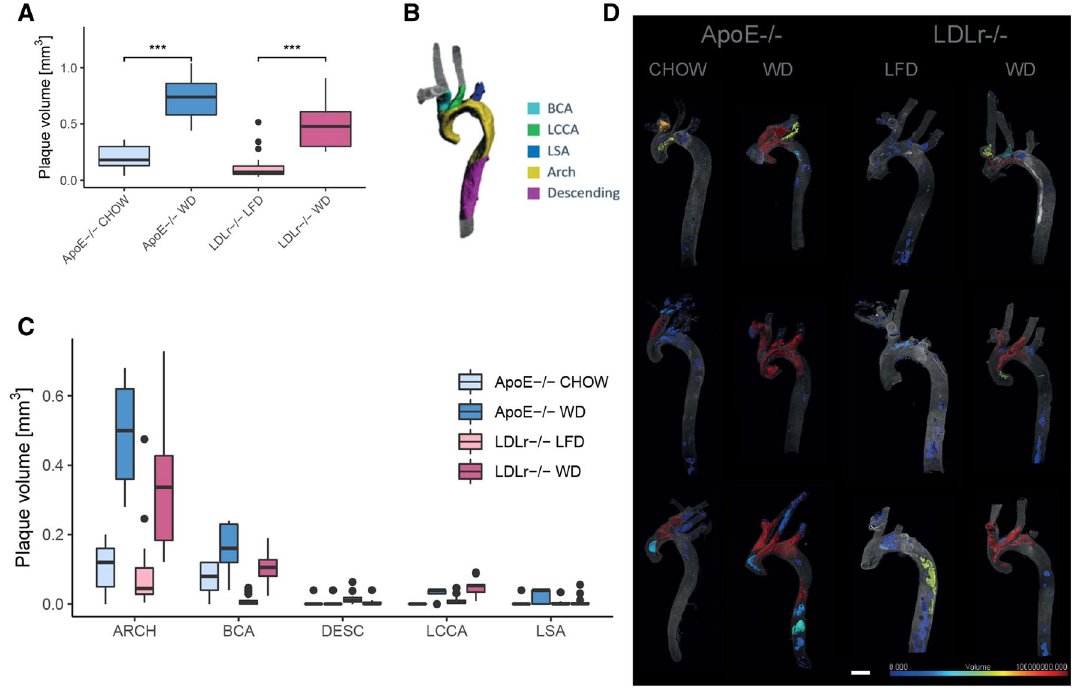
Figure 2. Plaque burden throughout the aorta and branching vessels. ( A ) Total plaque volume in ApoE−/− and LDLr−/− mice on different diets. Plaque volume is significantly increased in mice on western diet (Man- Whitney test, ApoE−/− p value = 0.0002, LDLr−/− p value = 1.15e-7). ( B ) Division of the aorta into 5 anatomical structures. ( C ) Plaque volume per anatomical structure. ( D ) Visualization of the sizes of individual plaque objects (scale bar 1000